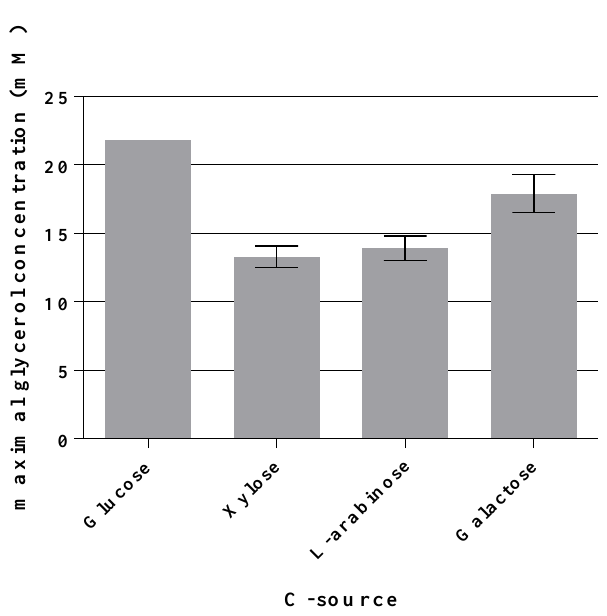
Figure 7. Maximal glycerol concentrations formed by GL7 during growth on different C-sources. Hexoses (D-glucose, D-galactose) were set at ≈28 mM initial concentrations, pentoses (L-arabinose, D-xylose) at ≈33 mM. Actual starting concentrations were determined by HPLC. Mean values of two independent biological replicates are given.